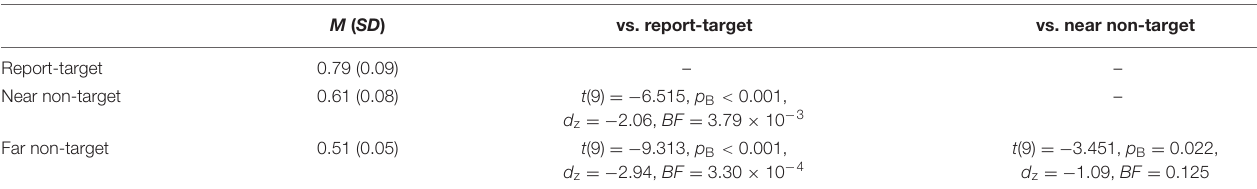
TABLE 1 | Probe recognition performance in the three conditions of Experiment 2 assessed as the proportion of correct responses to the probe. M ( SD